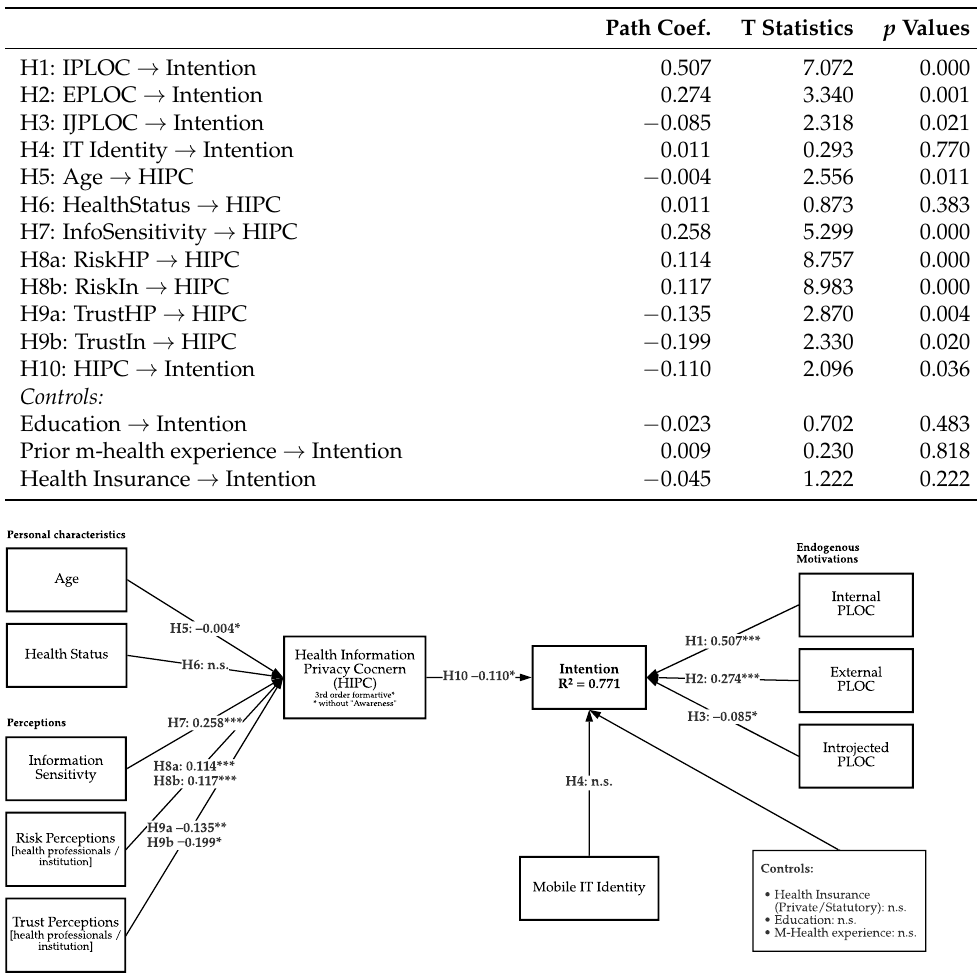
Table 2. Results for test hypotheses and control variables.